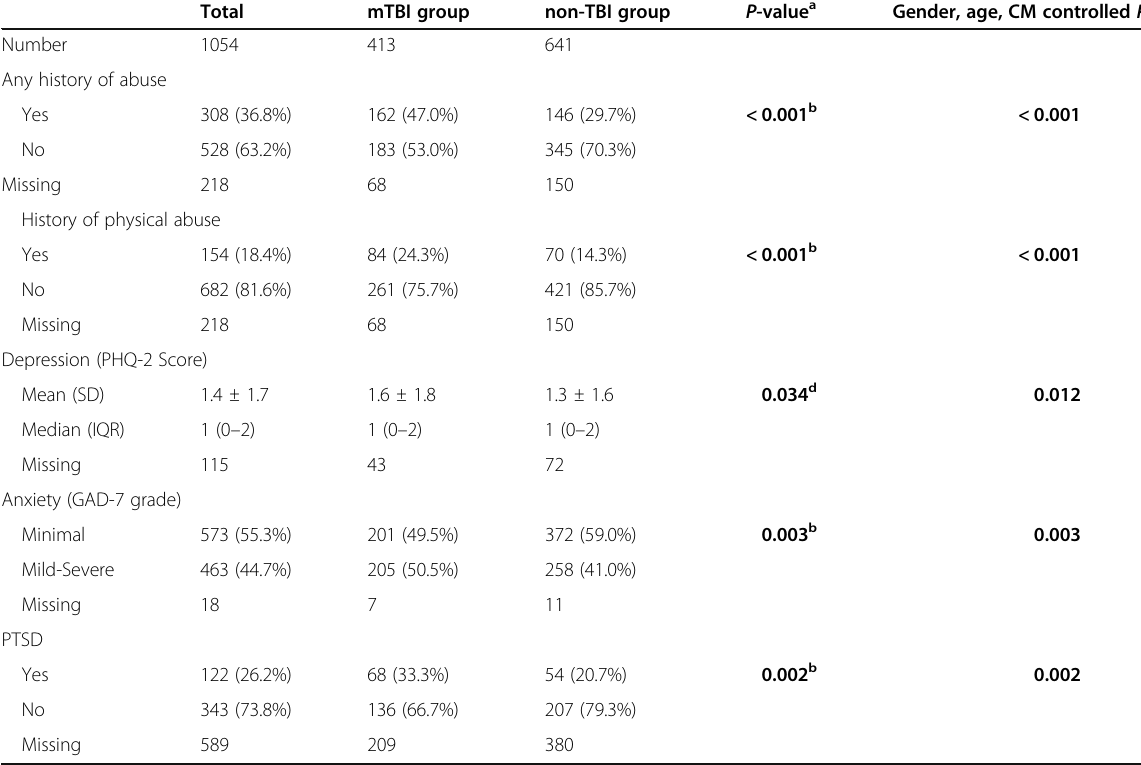
Table 6 Past history of abuse and psychiatric